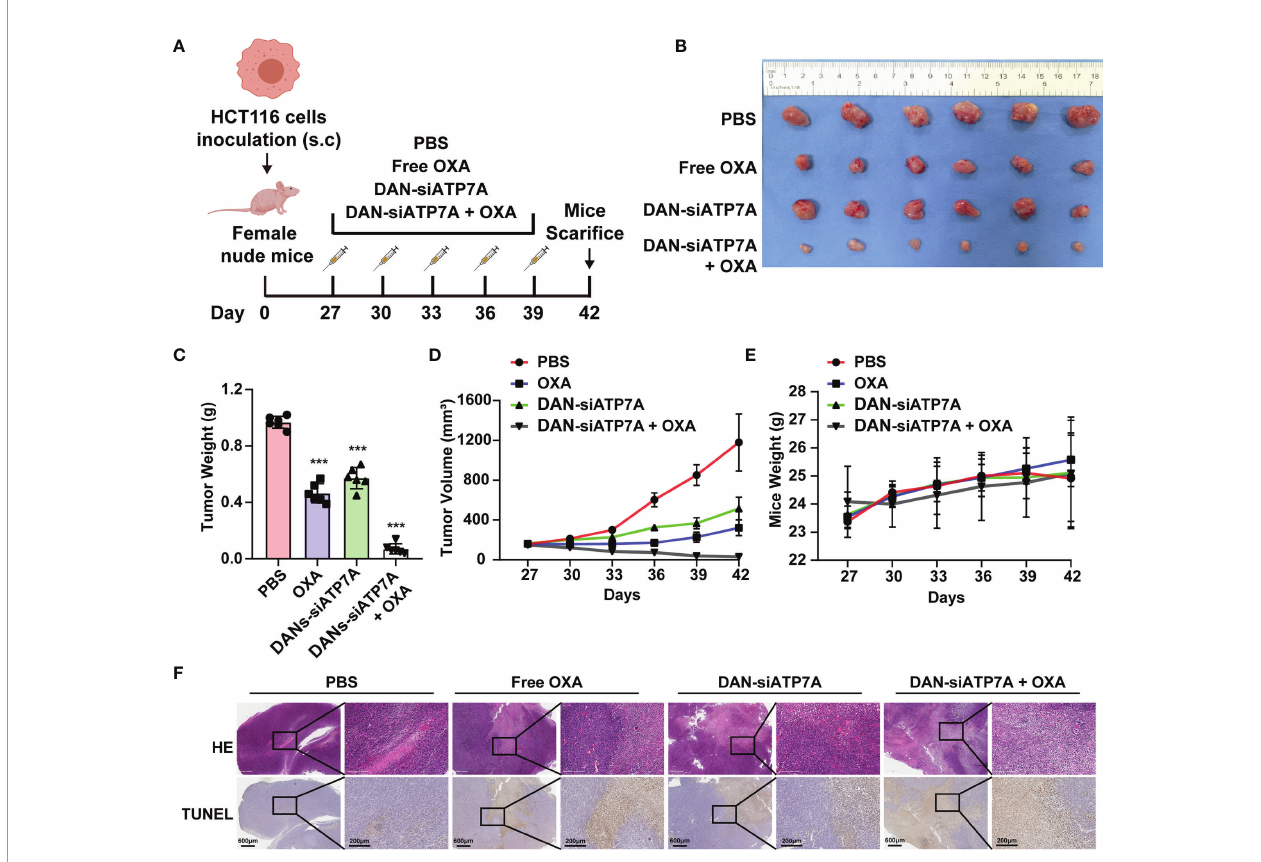
FIGURE 5 | siRNA-loaded nanoparticle reverses chemoresistance in HCT116-bearing mice. (A) The scheme of medication on tumor-bearing mice. (B) The image of the tumor was dissected from the nude mice at the end of the in vivo study. Tumor weight (C) , tumor volume (D) and mice weight (E) after the treatment. (F) The HE staining and TUNEL analysis of the tumor tissue of the nude mice. ***P < 0.001 when compared to the control